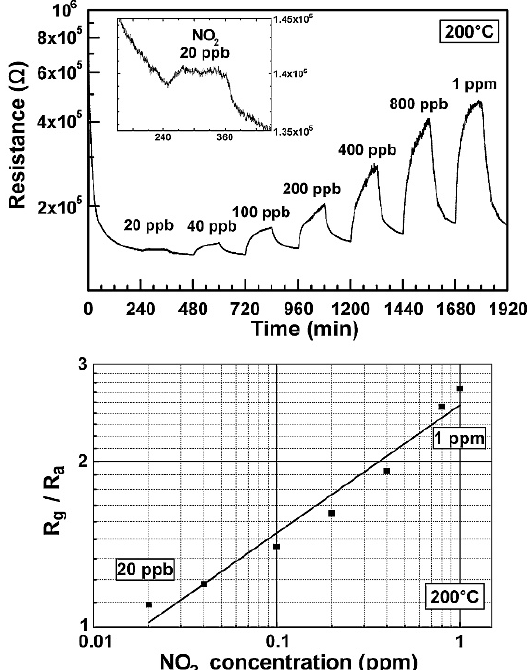
Figure 14. Top panel: dynamic response in dry air of the MoS 2 device annealed at 250 ◦ C to NO 2 concentrations ranging from 20 ppb to 1 ppm, at OT = 200 ◦ C; Bottom panel: calibration curve of the device. (Reprinted from [164], with permission from Elsevier, Amsterdam, The Netherlands).